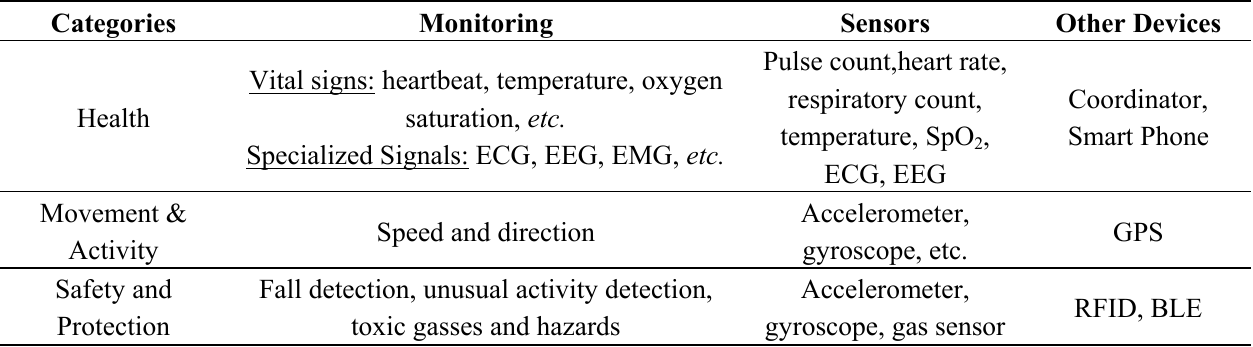
Table 15. Monitoring requirements for workers safety